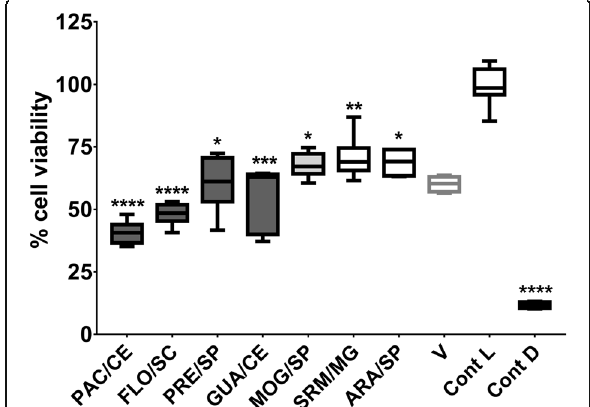
Fig. 7 Cell viability of keratinocytes NOK-si after exposure to selected extracts. The data described are the medians and the interquartile ranges. The data described are median (traces) and interquartis (boxes). The error bars represent the maximum and minimum values. “ Cont L ” indicates cell viability control and “ Cont D ” , the cell death control. The percentage of cell viability was obtained considering the cell viability control as 100%. The asterisks denote a statistically significant difference of a specific extract versus cell viability control control (Cont L), where **** p < 0.0001, *** p = 0.0004, ** p = 0.0088, and * p ≤ 0.0204 (Kruskal-Wallis test, followed by the multiple comparison test of Dunn). The colors of the bars of the graph represent the variety of the extracts, being, in dark gray: var. sylvestris ; in light gray: var. intermediate; and blank: var.